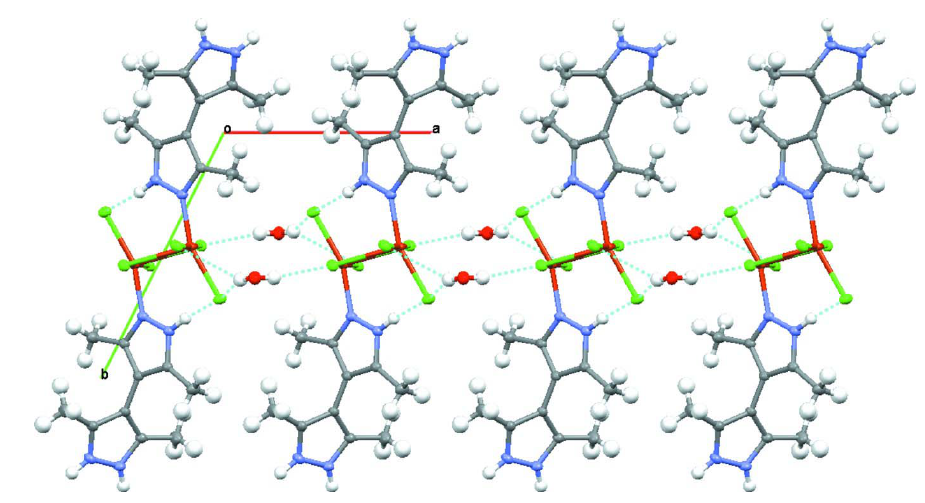
Figure 1 The molecular structure of I with atom labels and 50% probability displacement ellipsoids for non-H atoms. [Symmetry codes: (A) - x + 2, - y + 3, - z + 1; (B) x , y - 1, z ]